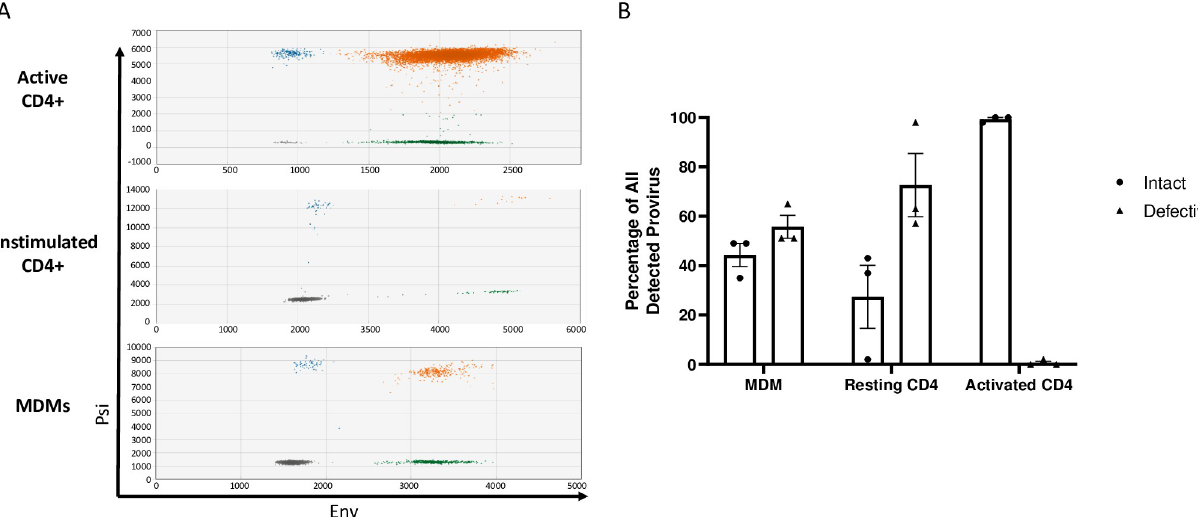
Fig 1. Acute HIV-1 infection generates defective proviruses in MDMs and resting CD4+ T cells. (A) Representative raw IPDA data of (top) activated CD4+ T cells, (middle) unstimulated CD4+ T cells, and (bottom) monocyte-derived macrophages (MDMs) infected with HIV-1. Droplets are color coded based on manual gating of positive and negative probe signals (gray = empty or double mutation/deletion droplets, blue = droplets single positive for psi , green = single positive env droplets, orange = double positive psi and env intact proviral droplets). A parallel reaction to detect the host cell gene RPP30 was used as a correction for DNA shearing. (B) Percentages of intact and defective HIV genomes detected in MDMs and CD4+ T cells following HIV-1 infection. MDMs were infected with HIV-1 NL4-3-BaL for 48 hours prior to DNA isolation. Resting and anti-CD3/CD-28 bead activated CD4+ T cells were infected with HIV-1 NL4-3-VSVg for 72 hours prior to DNA isolation. Data represents three independent infections using cells generated from three different donors. Resting and activated CD4+ T cell sample data are participant matched. https://doi.org/10.1371/journal.ppat.1009982.g001 PLOS Pathogens| https://doi.org/10.1371/journal.ppat.1009982 December 28,